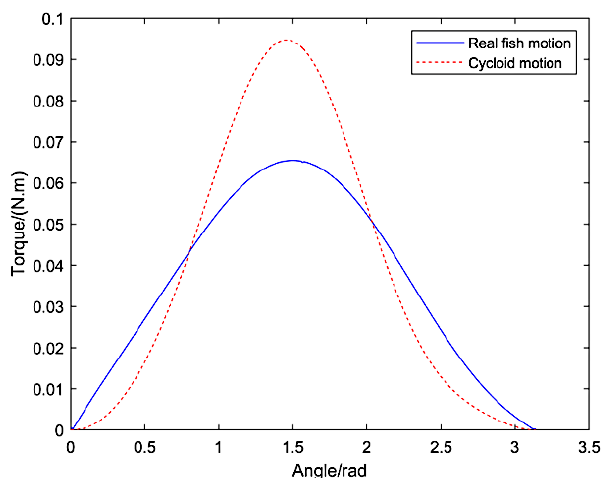
Figure 4. The driving torque for each motion.